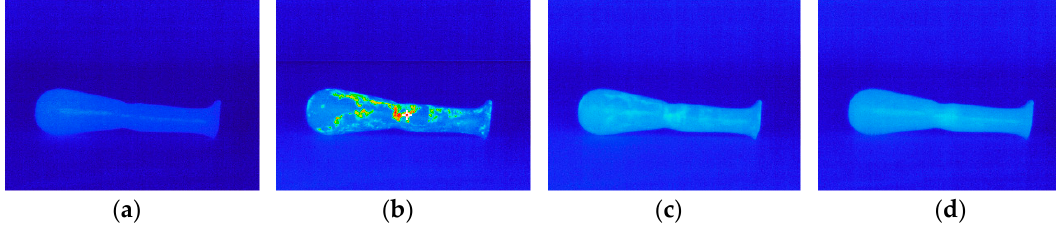
Figure 3. Raw thermogram sequence of the sample 1462 using flash lamps with white diffuser: ( a ) before the excitation pulse, ( b ) 0.03 second after pulse, ( c ) 0.24 second after pulse, ( d ) 1 second after